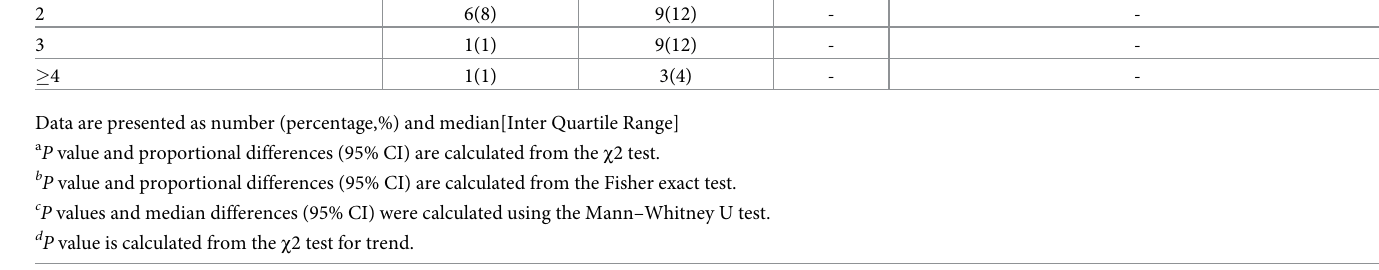
patients. Thus, the DNTP method is more effective than the conventional method for radial artery cannulation in elderly patients. The inner guide needle is removed immediately after the anterior wall puncture in the con- ventional method. Only the soft outer catheter slides into the inside of the blood vessel, which